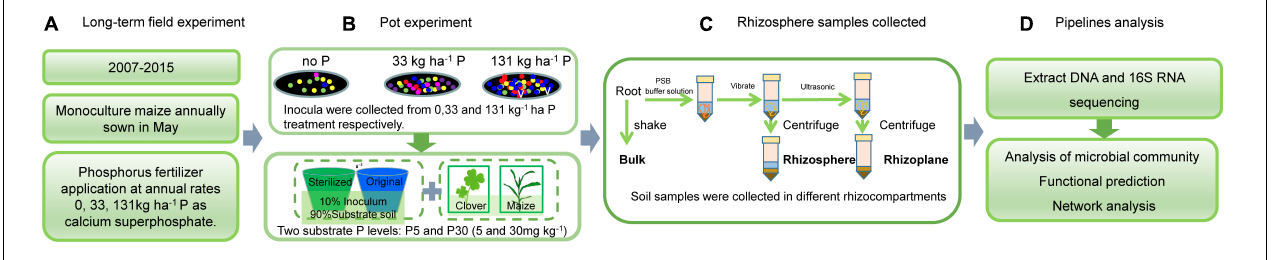
FIGURE 1 | Flow diagram of the